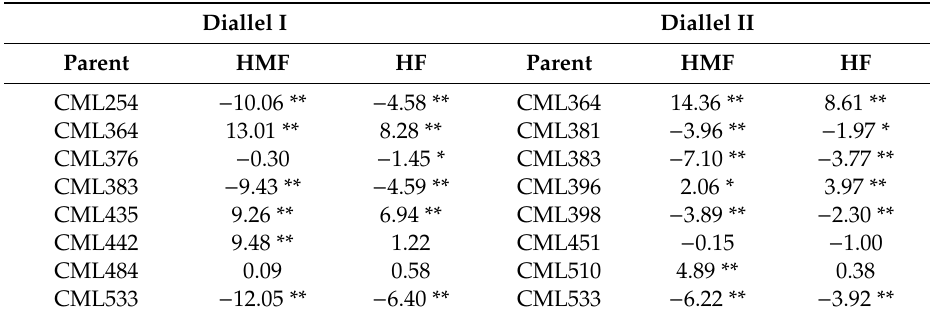
Table 5. Estimates of general-combining-ability e ff ects for the parental lines used in two diallels, for HMF and HF. Diallel